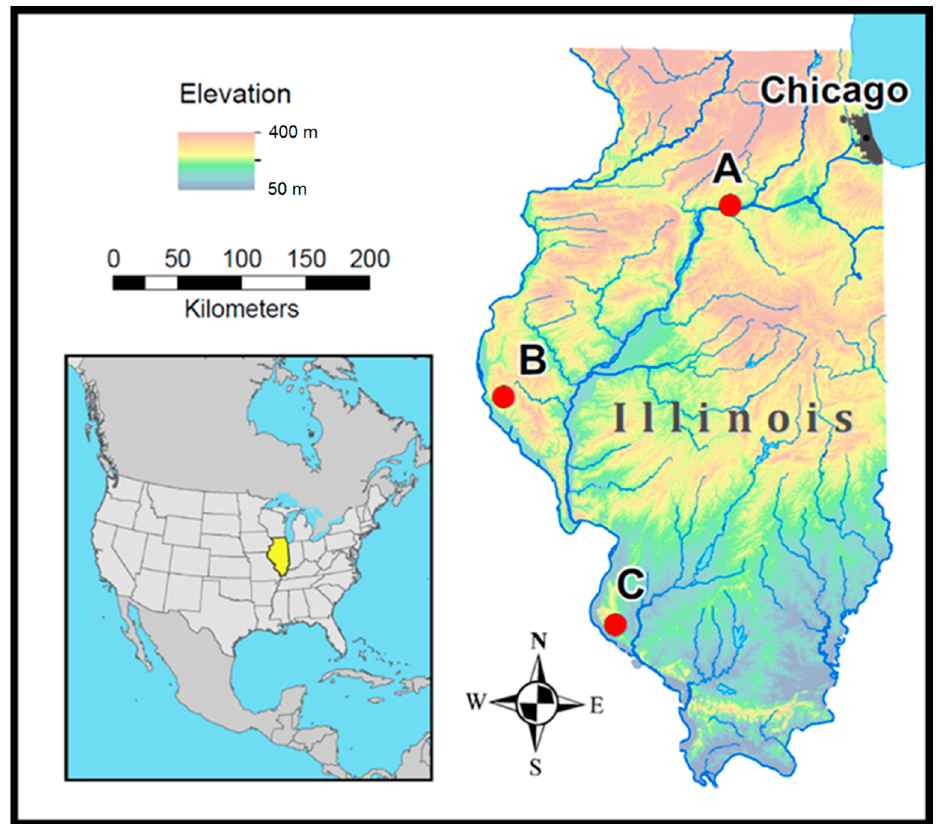
Figure 1. Location of sampling sites in Illinois. Red dots indicate sampling locations. Map generated using ESRI ArcMap 10.6.